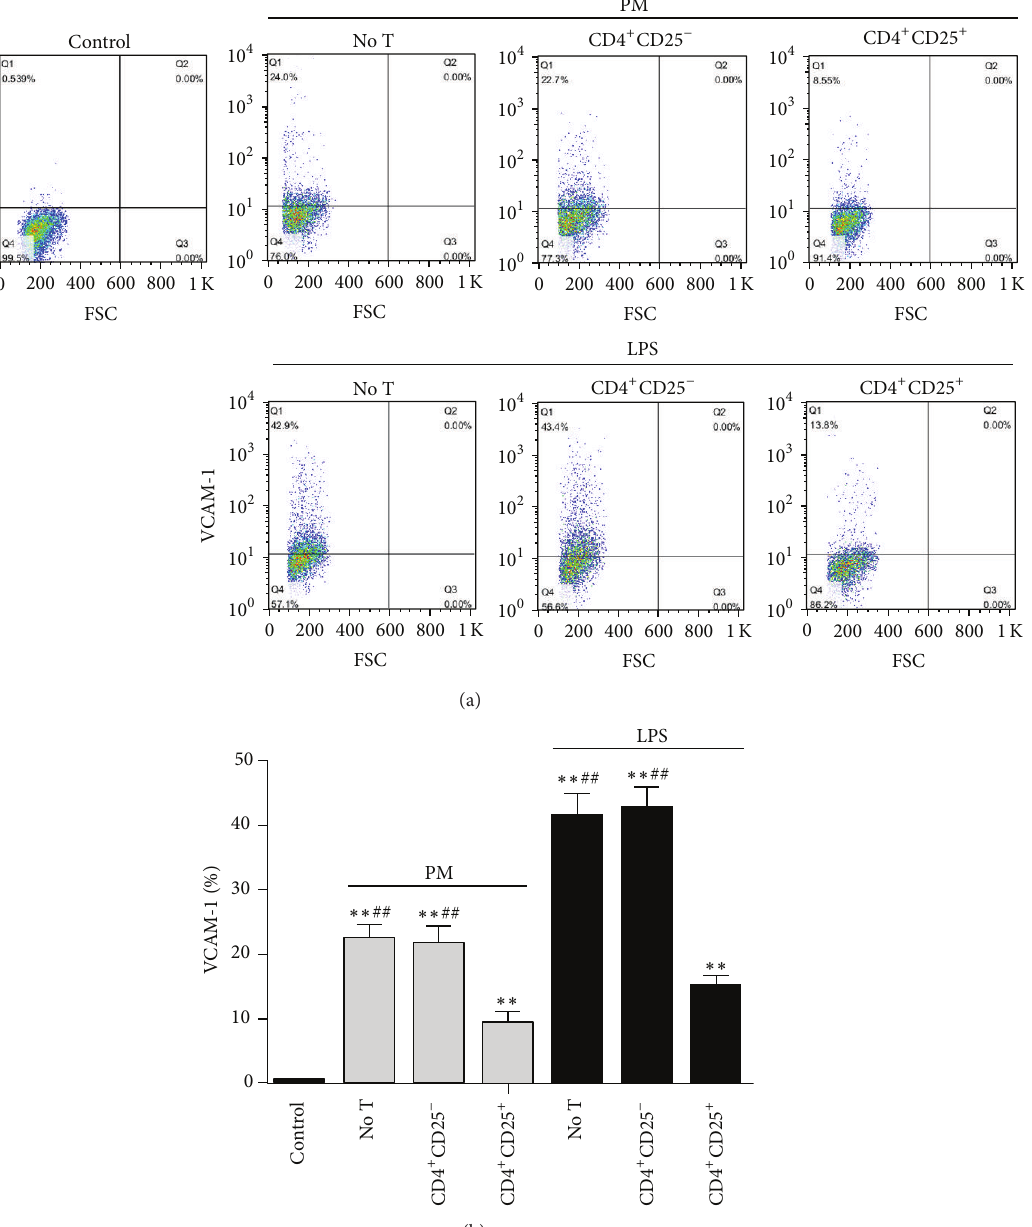
Figure 3: Tregs alleviate the expression of VCAM-1 in PM-exposed HUVECs. After the coculture period, HUVECs from different groups were harvested, and the VCAM-1 expression was detected by flow cytometry. (a) Dot plots showing the percentages of VCAM-1 expression in HUVECs. (b) The VCAM-1 expression in different groups of HUVECs. Data are expressed as means ± SEM. ∗ indicates no T, CD4 + CD25 − , or CD4 + CD25 + versus control; # indicates no T or CD4 + CD25 − versus CD4 + CD25 + ; ∗∗ 𝑃 < 0.01 ; ## 𝑃 < 0.01 . Experiments were repeated 6